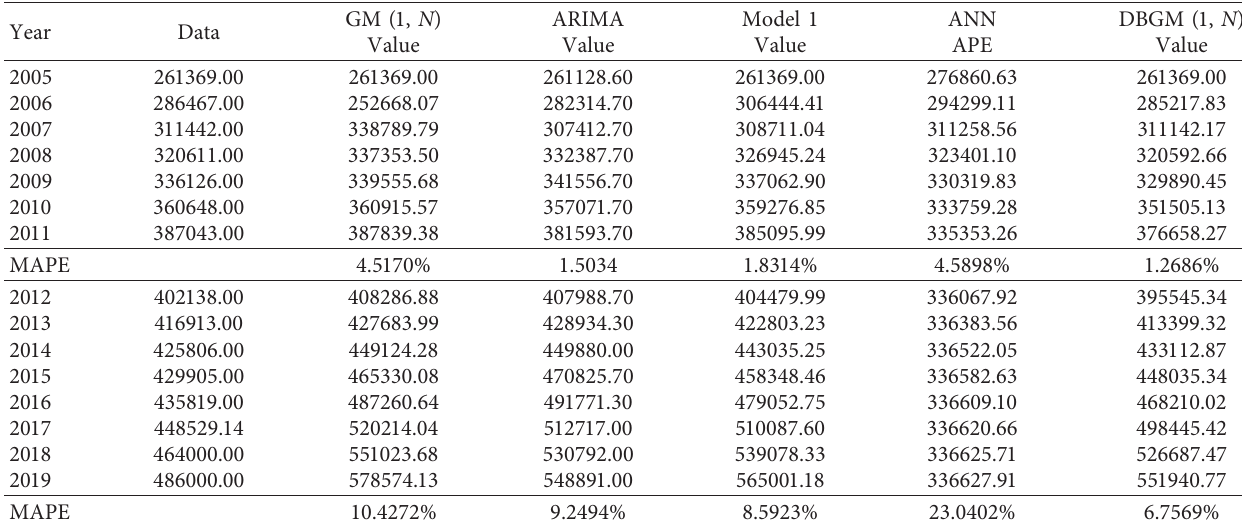
Table 4: The predicted values and APEs of the GM (1, N ) model, Model 1, and DBGM (1, N ) model in Case 2.